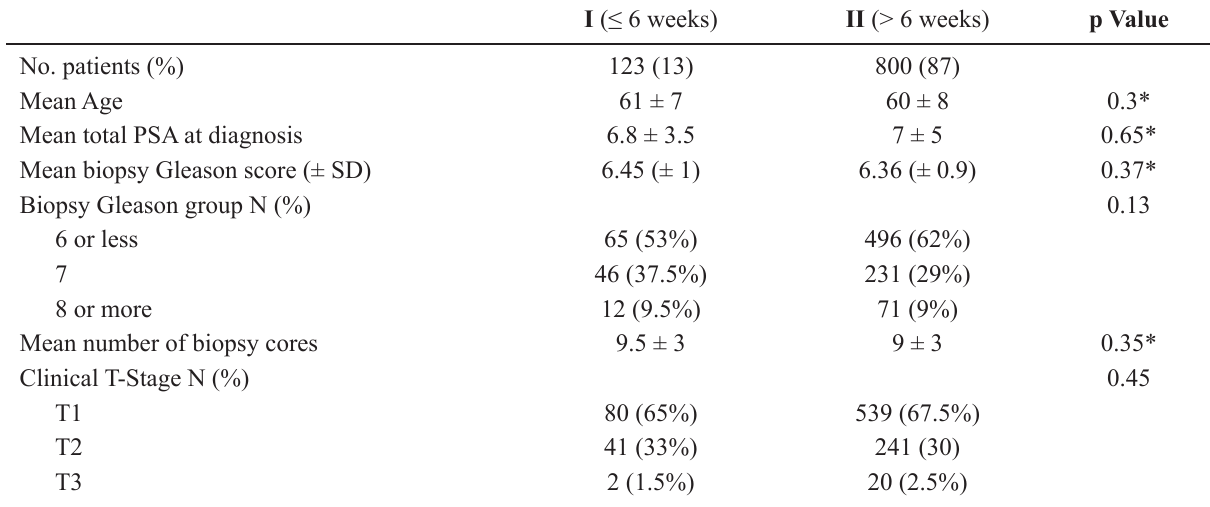
Table 1 – Comparison of preoperative